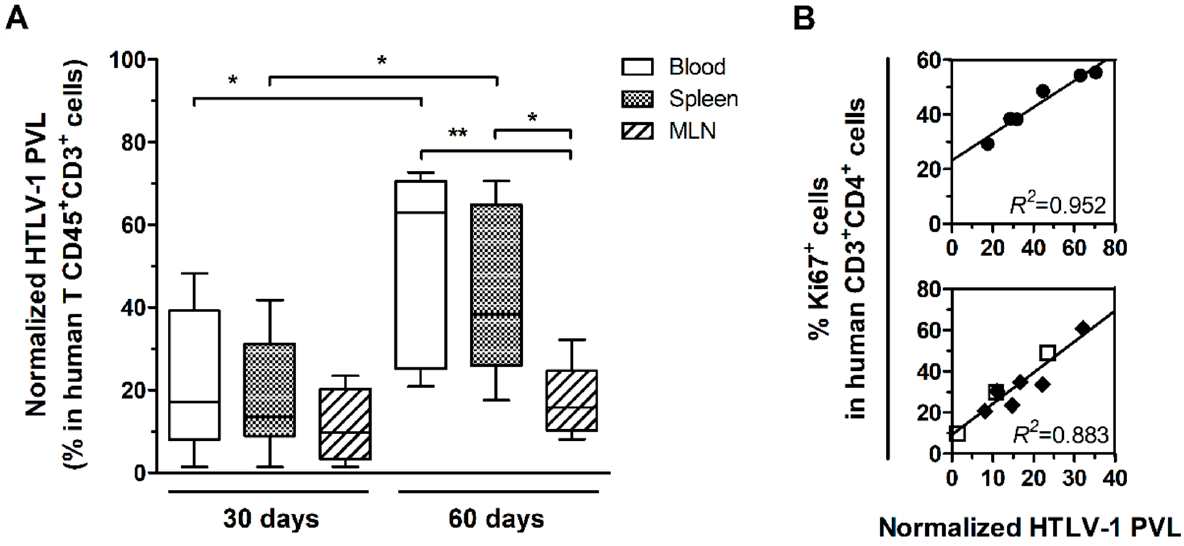
Figure 1. HTLV-1 proviral load in infected HIS-NSG mice. Blood, spleen, and mesenteric lymph nodes (MLN) from HTLV-1-infected mice were collected 30 days ( n = 8) and 60 days ( n = 6) post-infection (p.i.). ( A ) HTLV-1 proviral load (PVL) was determined by quantitative PCR in total DNA and then normalized by the frequency of human T-cells (CD45 + CD3 + cells). Statistical analysis was performed with Student’s t -test (*, p < 0.05; **, p < 0.01). ( B ) Proliferating CD4 + T-cells were identified as Ki67 + cells by flow cytometry after intracellular staining of fresh cells. Linear regression ( R 2 ) between the normalized PVL and the frequency of Ki67 + CD4 + T-cells is shown in the spleen ( • ) of mice at 60 days p.i. and in the MLN of mice at 30 days ( □ ) and 60 days p.i. ( ) combined.